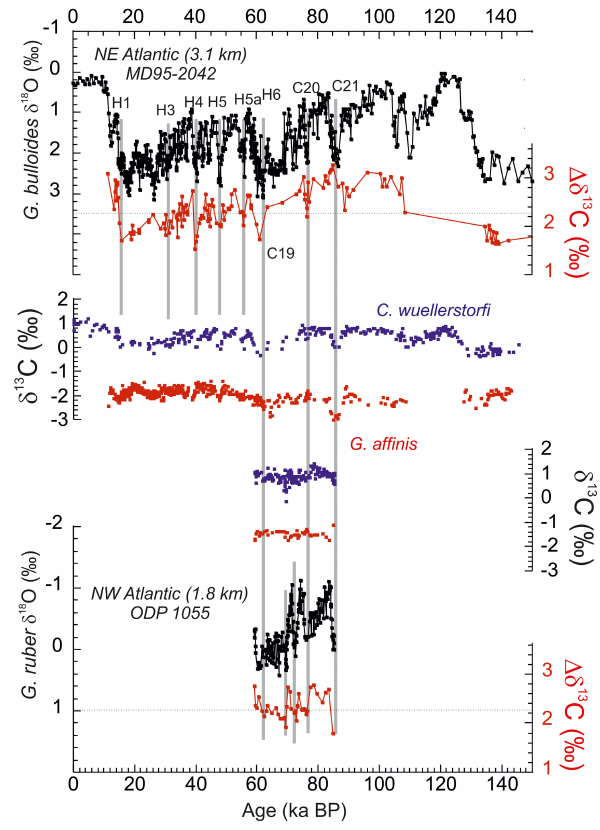
Figure 4. Benthic foraminifera (cid:49)δ 13 C at deep site MD95-2042 and intermediate ODP Site 1055 and their planktonic foraminifera oxy- gen isotopes. Original benthic foraminifera δ 13 C records (MD95- 2042 from Shackleton et al., 2000) of epifaunal C. wuellerstorfi (red circles) and deep infaunal G. affinis (blue circles) are also shown in- tercalated between the (cid:49)δ 13 C records. Several Heinrich events and cold events are shown.